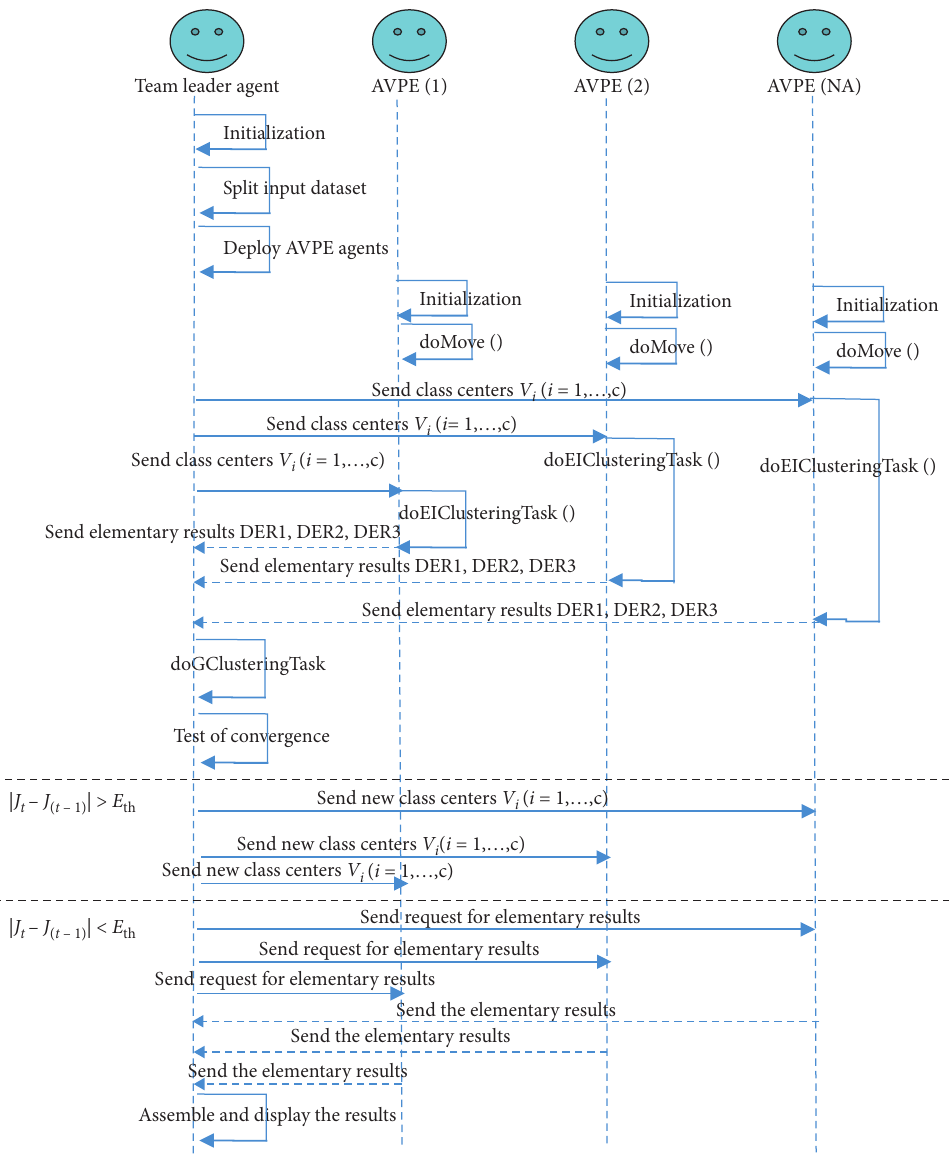
Figure 3: Distributed type-2 Fuzzy logic method based on mobile agent team